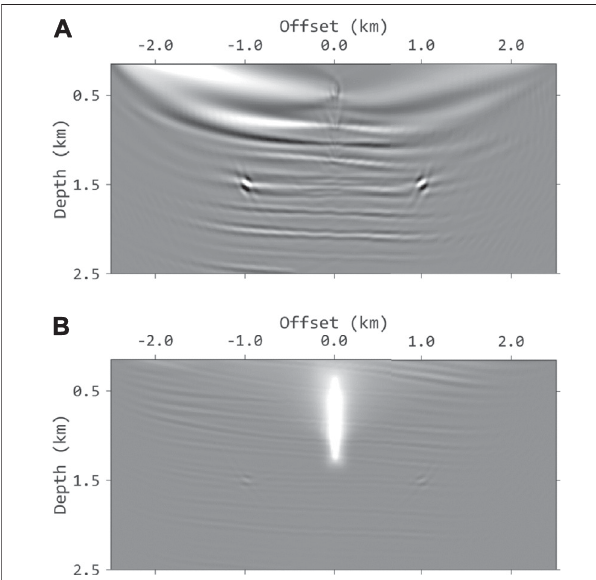
FIGURE 6 | The images generated by conventional cross-correlation imaging condition. (A) The image using primaries only. (B) The image using DDM. (B) haswidercoveragebyinvolvingmultiplesinthemigration.Theyboth have noises introduced by the two-way wave-equation used in RTM.